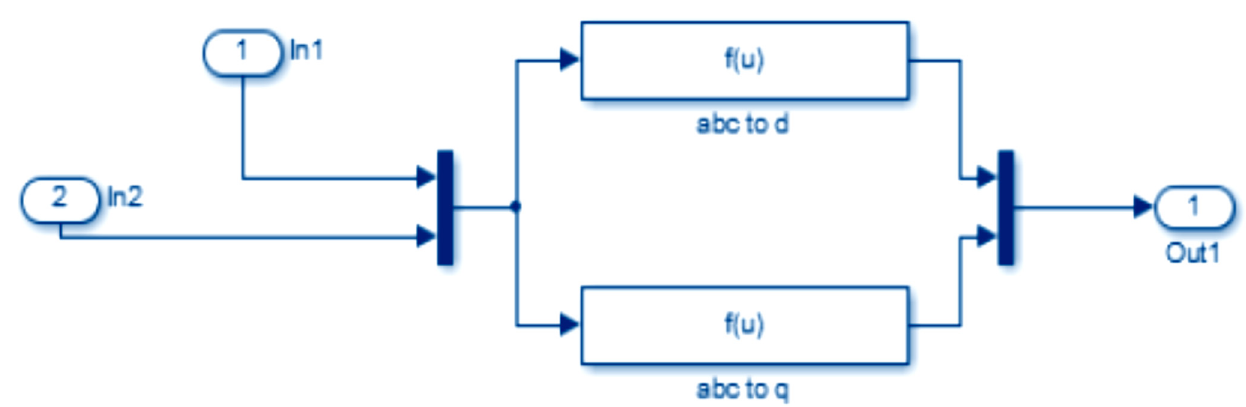
Figure 7. ABC to dq transformation.